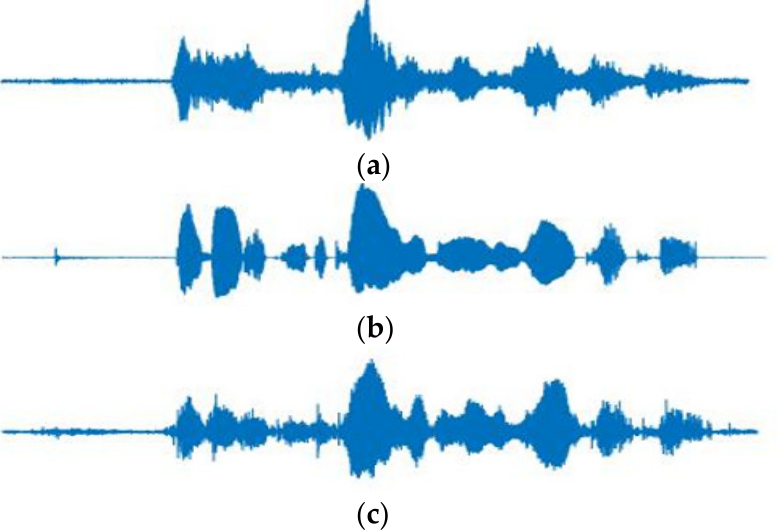
Figure 6. Waveform examples of ( a ) the recorded signal, ( b ) the signal artificially generated by RIR, and ( c ) the signal generated by the proposed method.